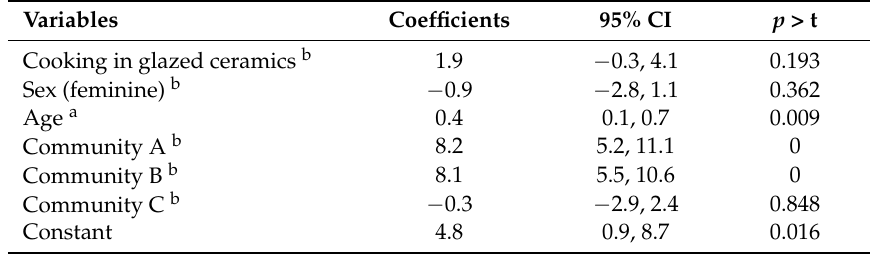
Table 3. Blood lead predictors 1 of exposed and non-exposed children to mining waste sites. Variables